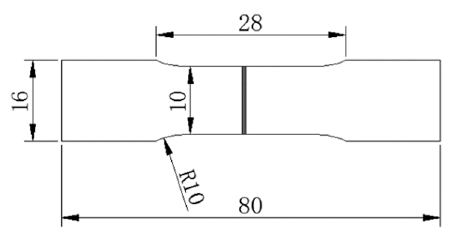
Figure 3. Schematic diagram of tensile sample size (unit: